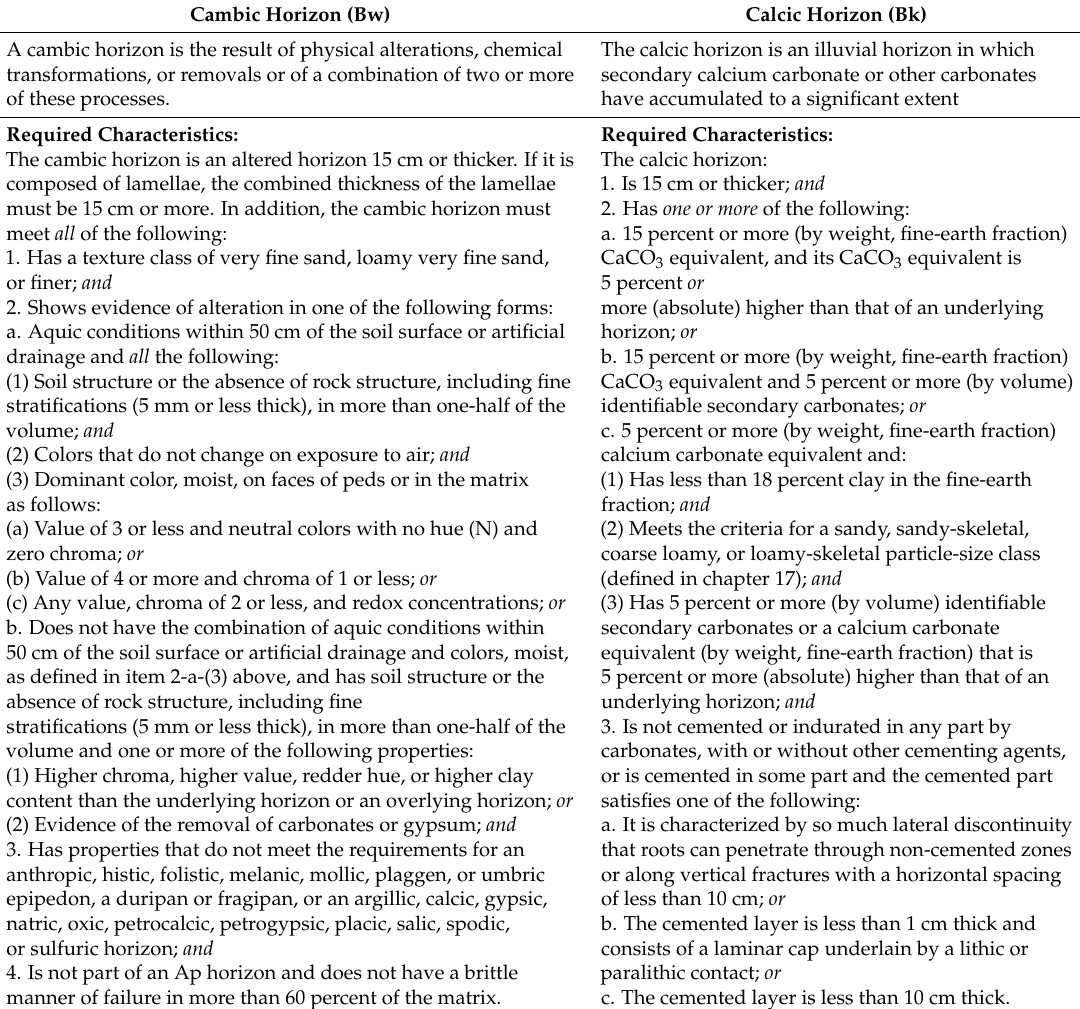
Table 4. Diagnostic horizons and characteristics of cambic and calcic horizons (modified from Keys to Soil Taxonomy